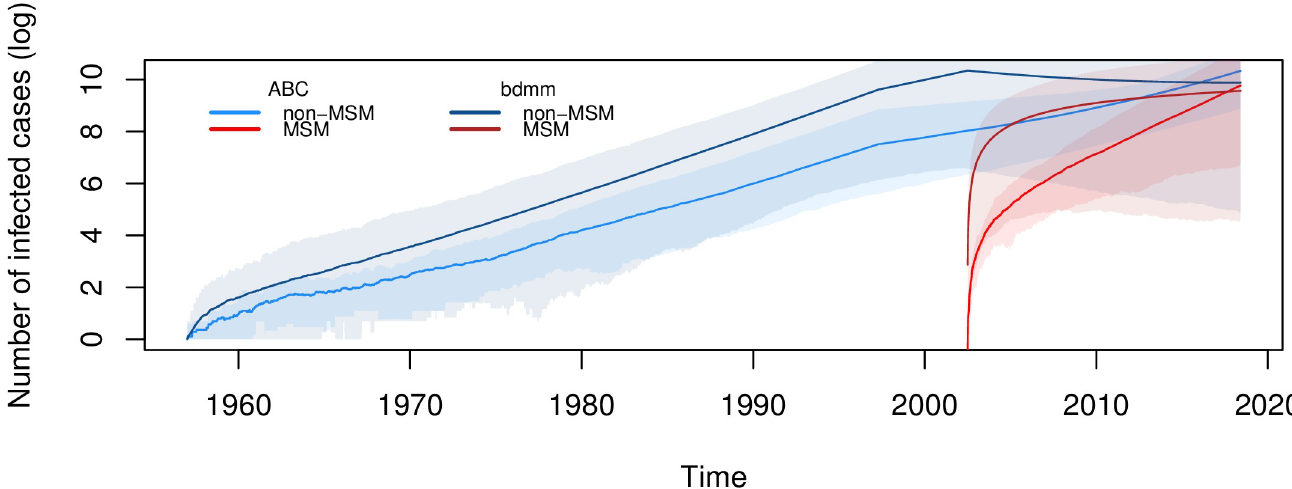
Fig 3. Epidemiological trajectories inferred from the virus sequence data using ABC or Beast2. The lines show the median natural logarithm values and the envelopes the 95% CI of trajectories corresponding to the number of infected cases through time, for each host type. Simulations were performed using the TiPS package from posterior distributions results of the ABC inference or the Beast2 bdmm